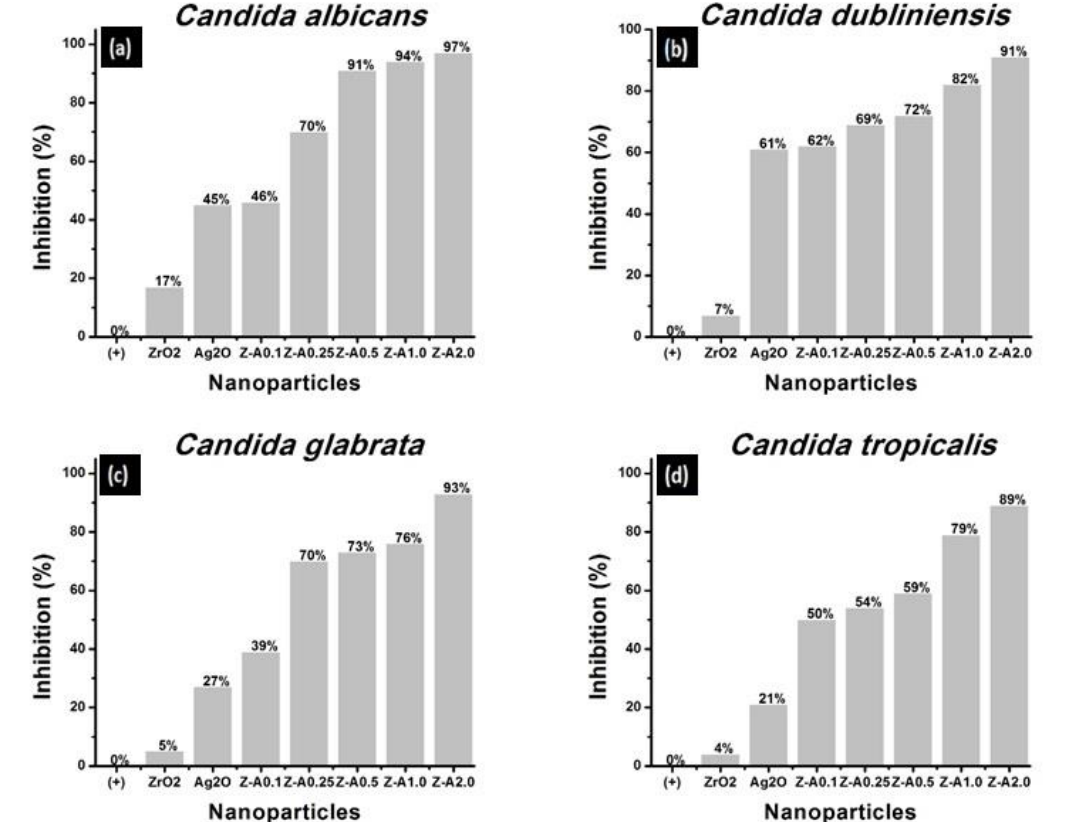
Figure 5. Comparison of the percentage inhibition of ZrO 2 , Ag 2 O, and Z-A nanoparticles against ( a ) C. albicans, ( b ) C. dubliniensis, ( c ) C. glabrata, ( d ) C. tropicalis .